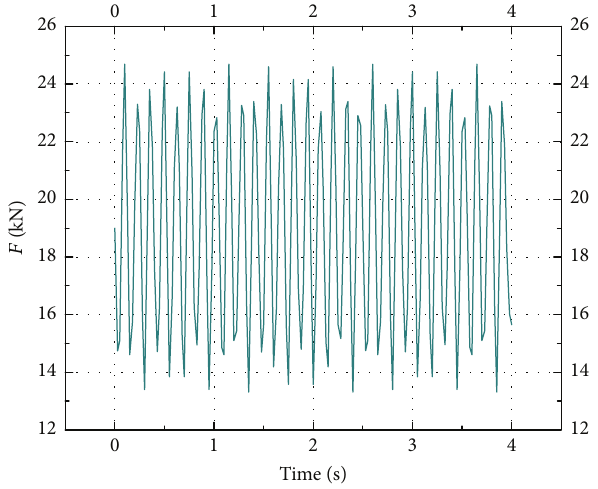
Figure 5: Vibrating load versus time curve.